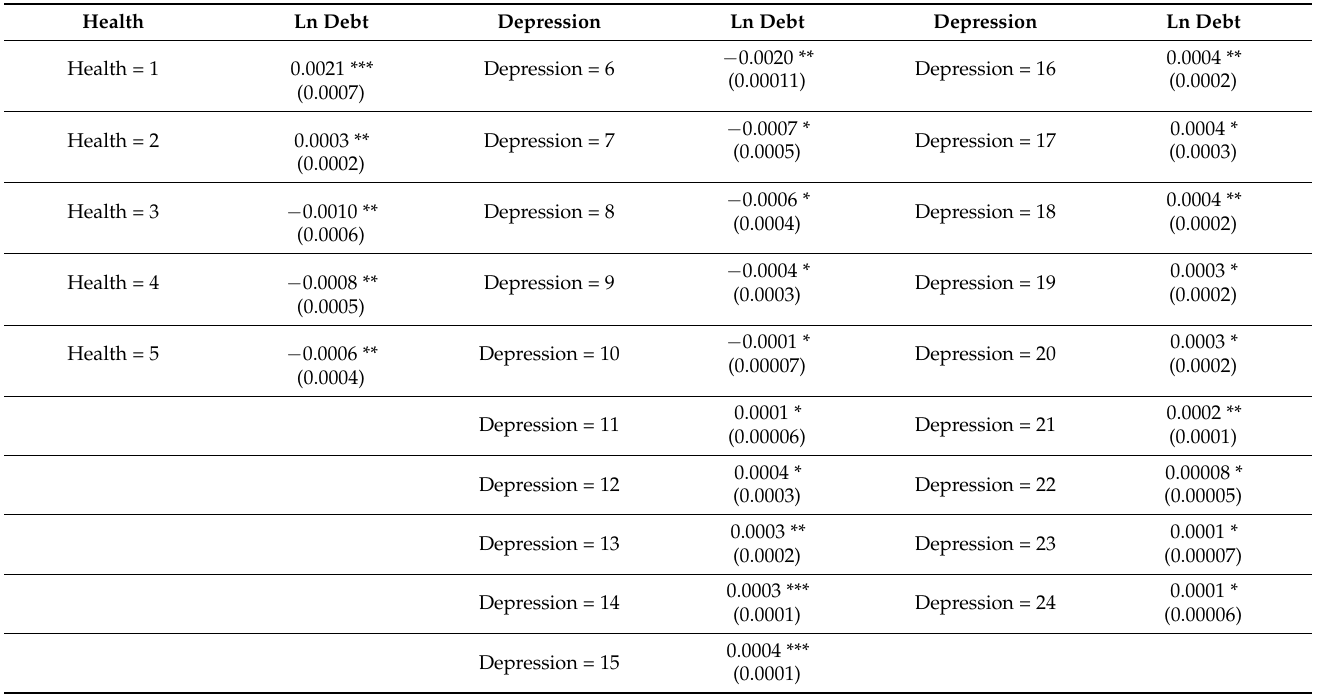
Table A6. Marginal effects of household debt in low income